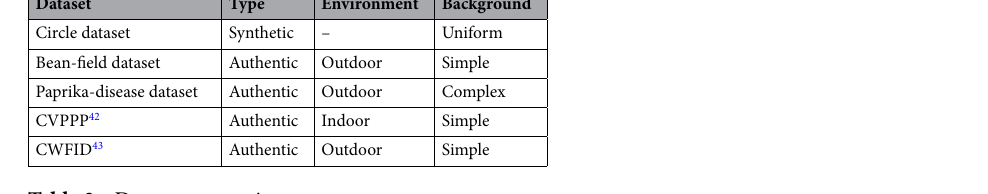
Table 2. Dataset properties.